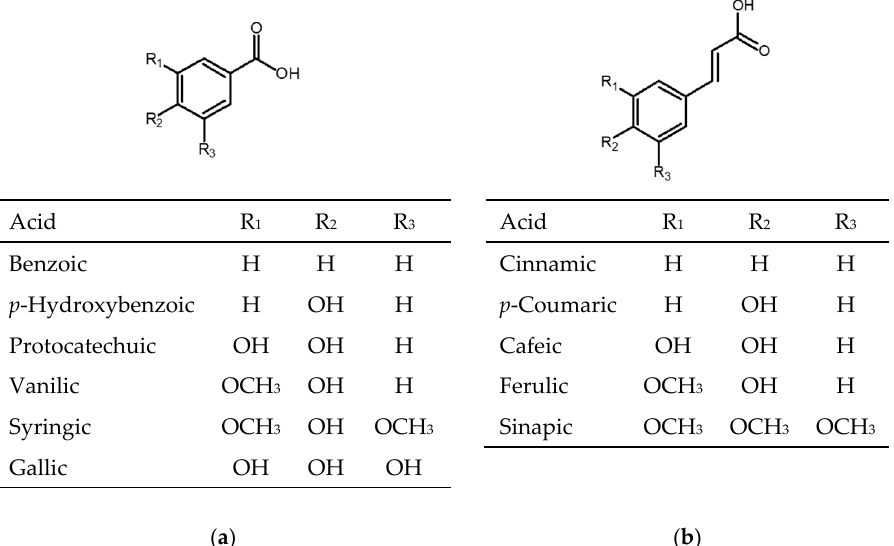
Figure 1. Chemical structures of phenolic acids: ( a ) derivates of hydroxybenzoic acid; ( b ) derivates of hydroxycinnamic acid.